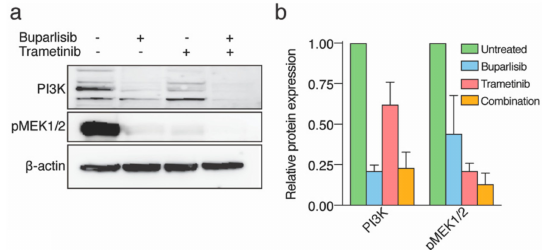
Figure 2. Protein expression of cell lysates after in vitro treatment with 10 µ M buparlisib, 10 µ M trametinib or combination (5 µ M + 5 µ M). ( a ) Western blots of lysates from H1 cells showing the expression of PI3K and MEK1 / 2; ( b ) quantification of PI3K and MEK1 / 2 expression relative to β